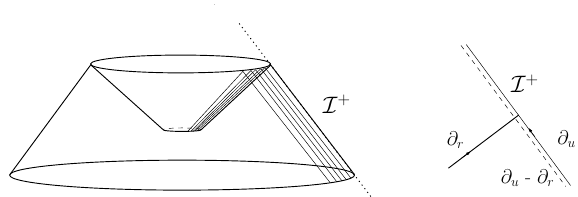
Figure 2 . Characteristic initial-value problem at I + . One prescribes data on a chosen u 0 hypersur- face of the foliation attached to future null in(cid:12)nity, plus the asymptotic transverse shear (cid:0) s 0 ( u; (cid:18); (cid:30) ). Thanks to the algebraic Bianchi identity (4.37), this can also be understood as prescribing a certain shear for the non-geodetic asymptotic null vector @ u (cid:0) @ r in the physical